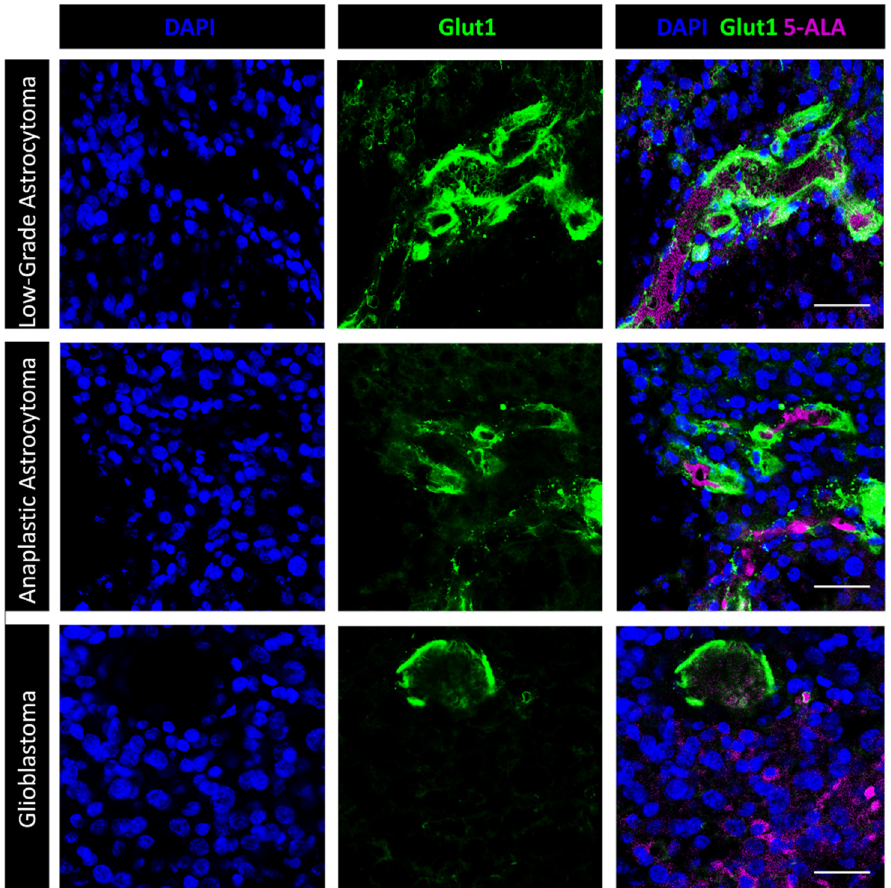
Figure 5. Fluorescence microscopy for 5-ALA and immunofluorescence with anti-Glut1. In low grade glioma (upper panels; Case #2 on Table 1), the dotted 5-ALA fluorescent signal is mostly confined to intravascular cells. A few fluorescent dots can be seen in perivascular cells. Glut1 is highly expressed by the endothelial cells. Scale bar, 40 µ m. In anaplastic glioma (middle panel; Case #4 on Table 1), the Glut1 staining lacks in many regions of the tumor vessels, suggesting BBB disruption. Mosaic and/or perivascular tumor cells show intense 5-ALA fluorescence. Scale bar, 40 µ m. Glioblastoma tumors (lower panels; Case #14 on Table 1) show several 5-ALA fluorescent cells even at distance from vessels with discontinuous Glut1 staining. Scale bar, 40 µ m. Objective lens, Olympus PlanApo N 60X/1.42 Oil.